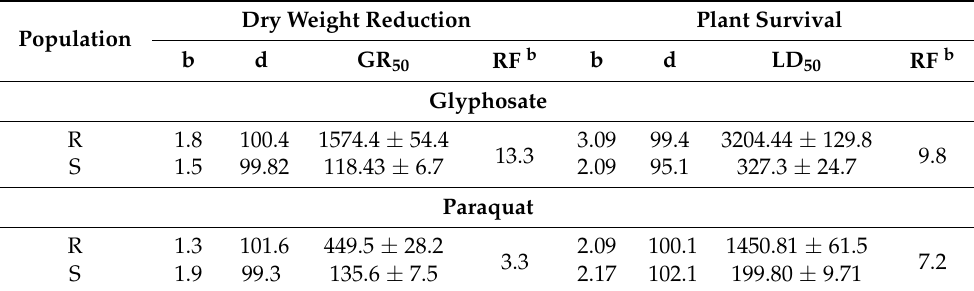
Table 2. Parameters of the log-logistic equations a used to estimate the glyphosate (g ae ha − 1 ) and paraquat (g ai ha − 1 ) rates required to reduce growth by 50% (GR 50 ) and lethal doses (LD 50 ) in susceptible and resistant Eleusine indica populations from Colombia. Dry Weight Reduction Plant Survival Population b d GR 50